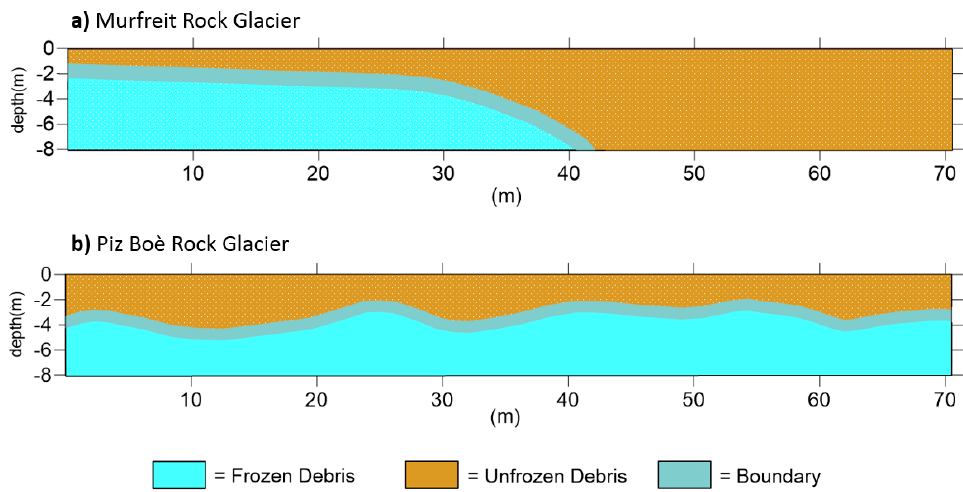
Figure 8. Ground interpretation in the investigation sites of ( a ) Murfreit rock glacier and ( b ) Piz Boè rock glacier, defined with the results of ERT and FDEM surveys. Boundary layer was suggested considering the uncertainties of the measurements.